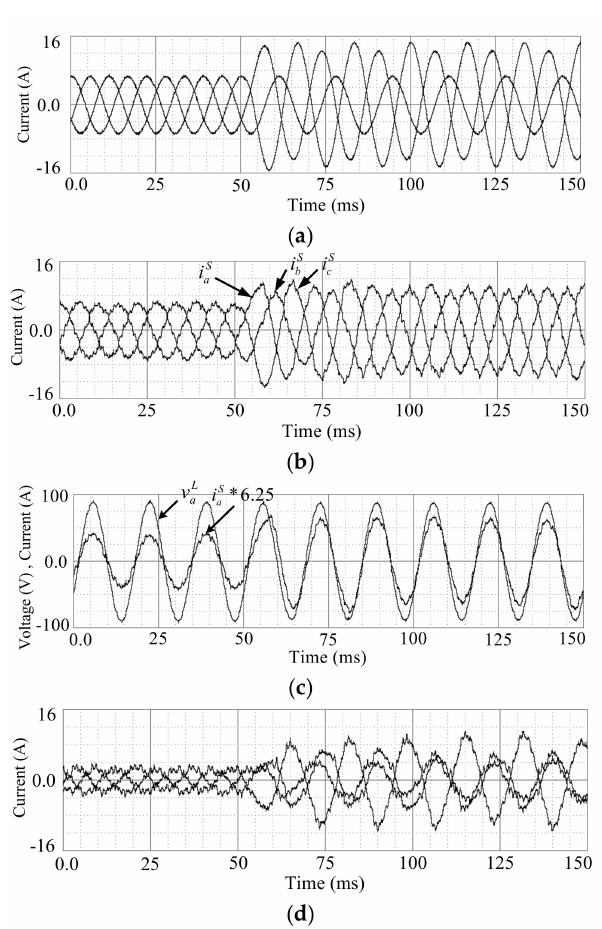
L i ) ; ( b ) , , a b c ; ( b ) Source a , b , c v i ); ( d ) Line current of the a a